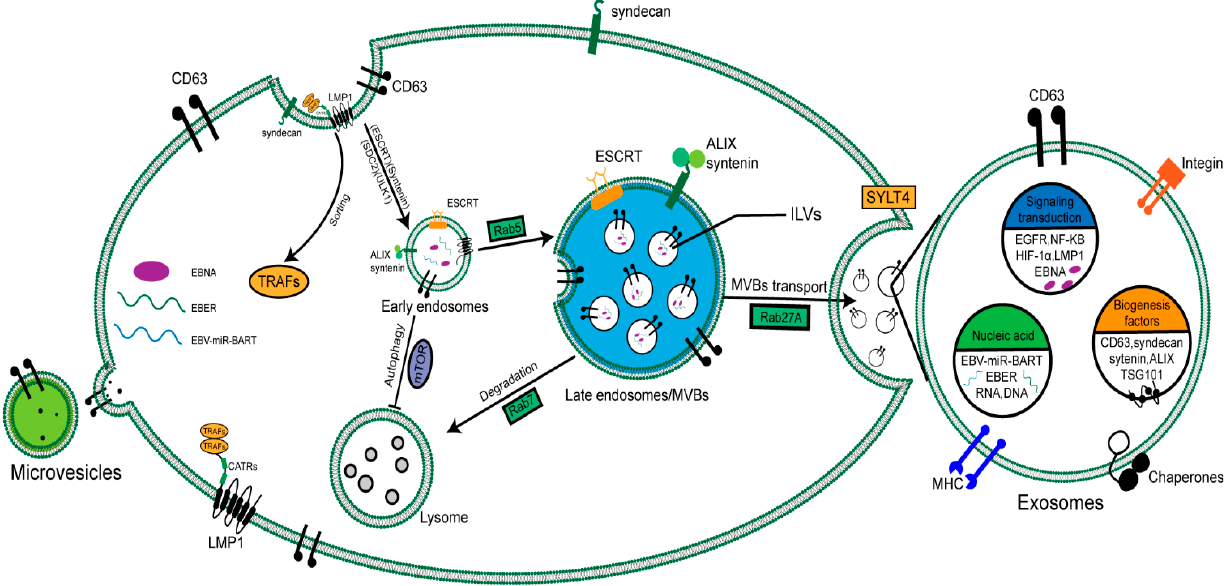
Figure 1. Biogenesis and secretion of extracellular vesicles in EBV-associated NP.